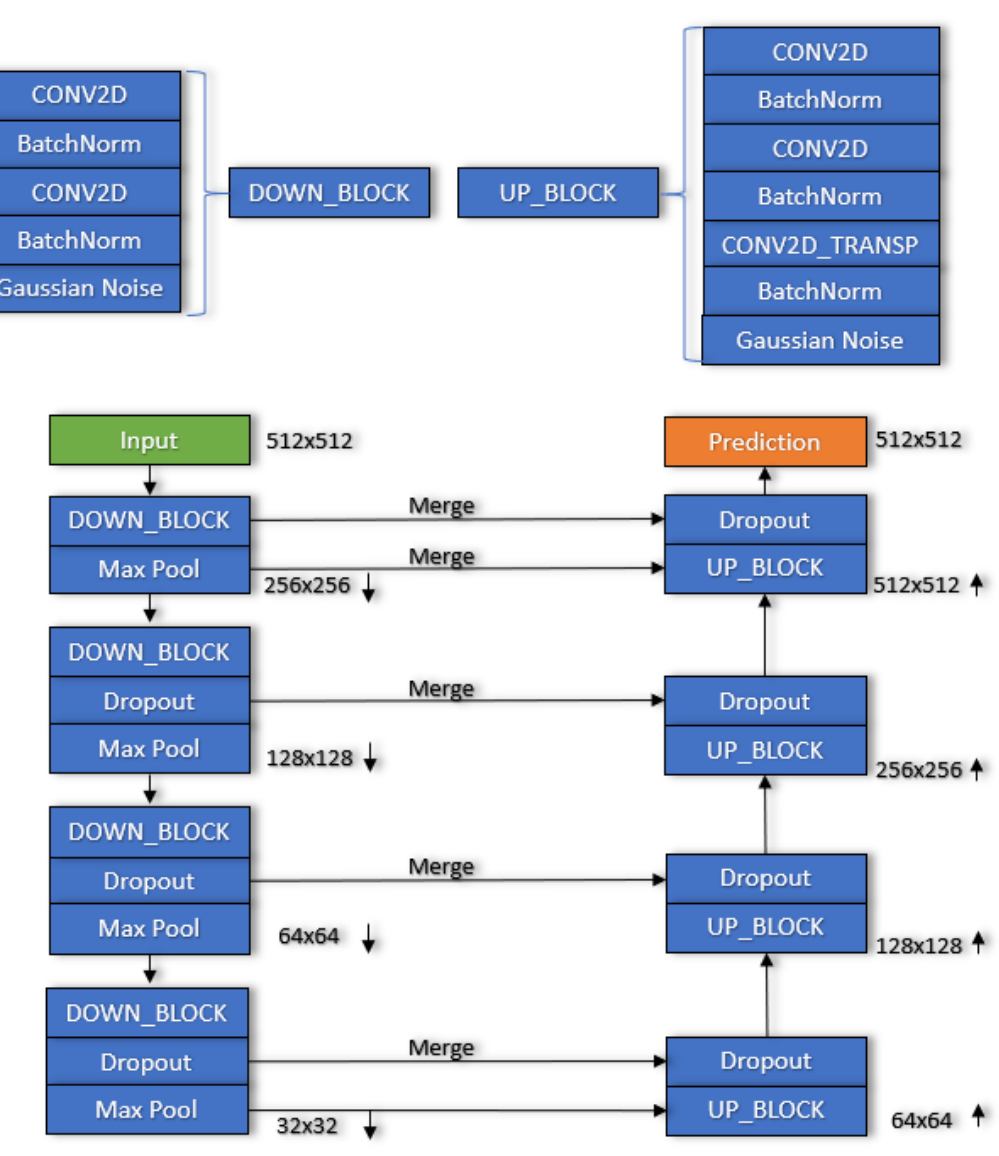
Figure 4. A map of the network architecture used in this study. Down-sampling and up-sampling convolutional blocks are defined